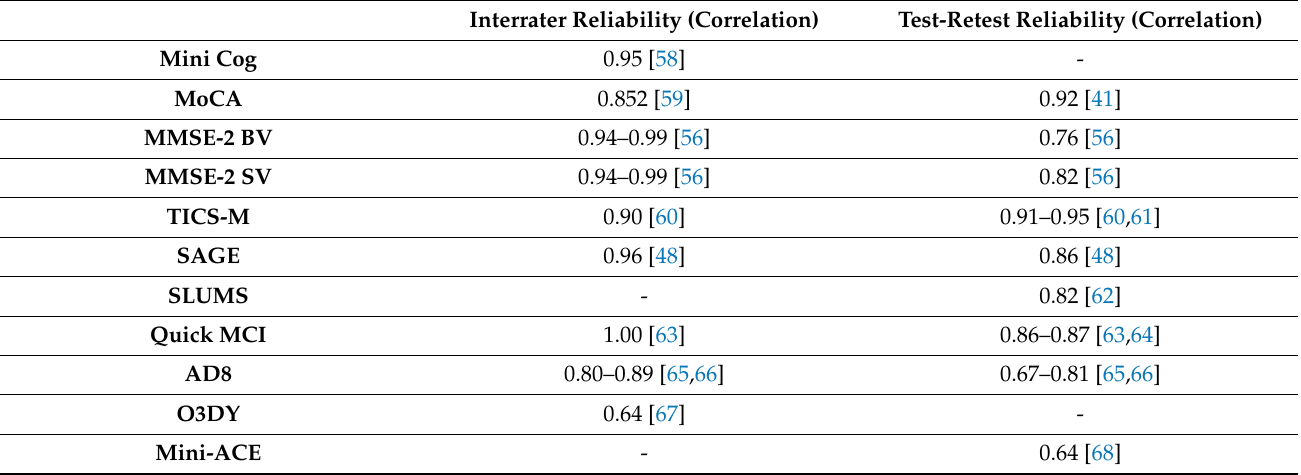
Table 3. This table shows the interrater reliability and the test-retest reliability of the included screeners. Interrater Reliability